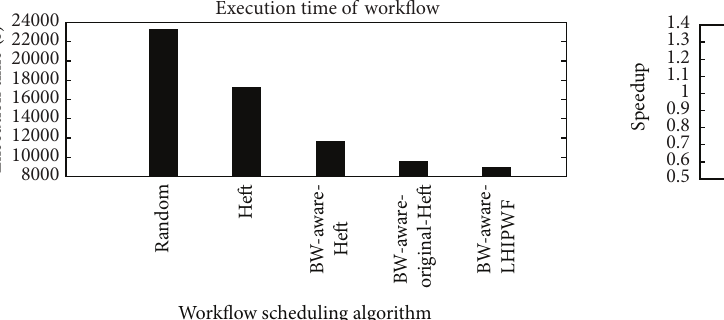
Figure 13: Comparison of the Speedup for the workflow of 41 tasks with large data communication.